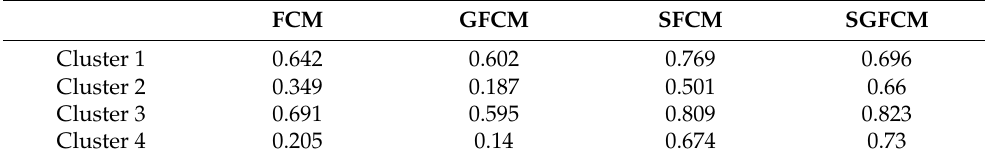
Table 6. Moran I index for the columns of the membership matrices among the four algorithms.